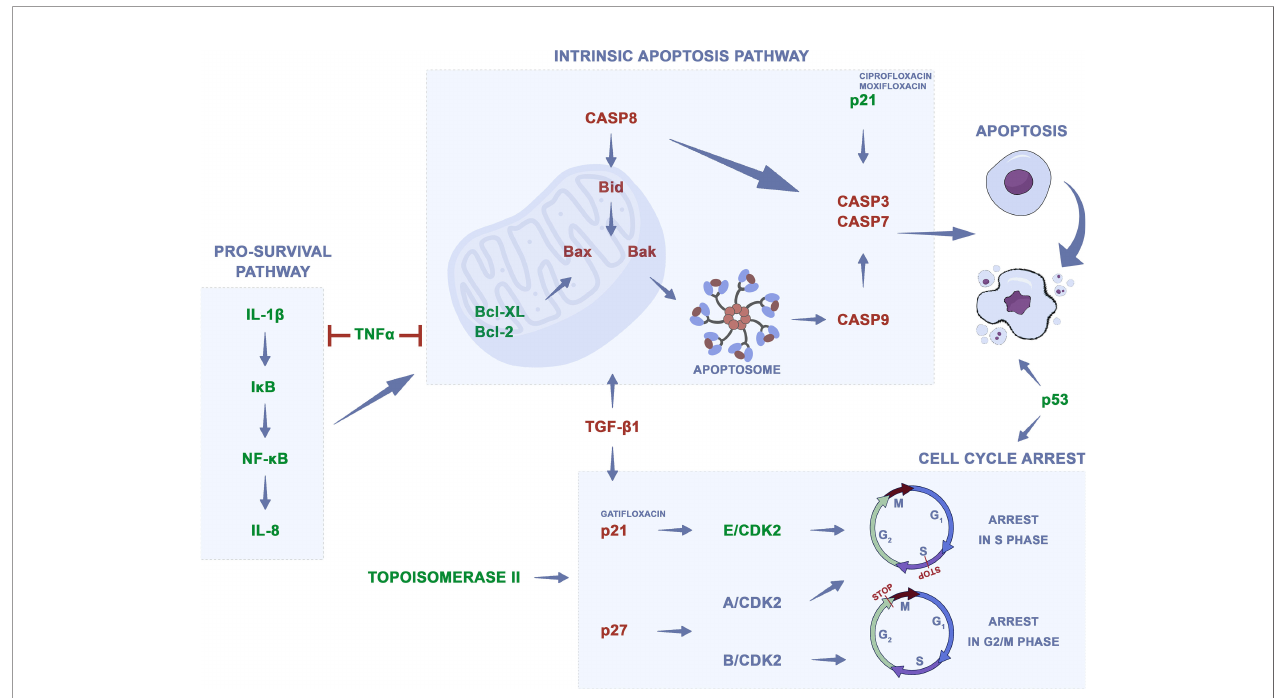
FIGURE 3 | Potential mechanism of quinolones action on cancer cells. Changes in gene regulation after quinolones treatment, which lead to apoptosis and cell cycle arrest, were presented on the basis of analyzed data. Green — downregulation, red —